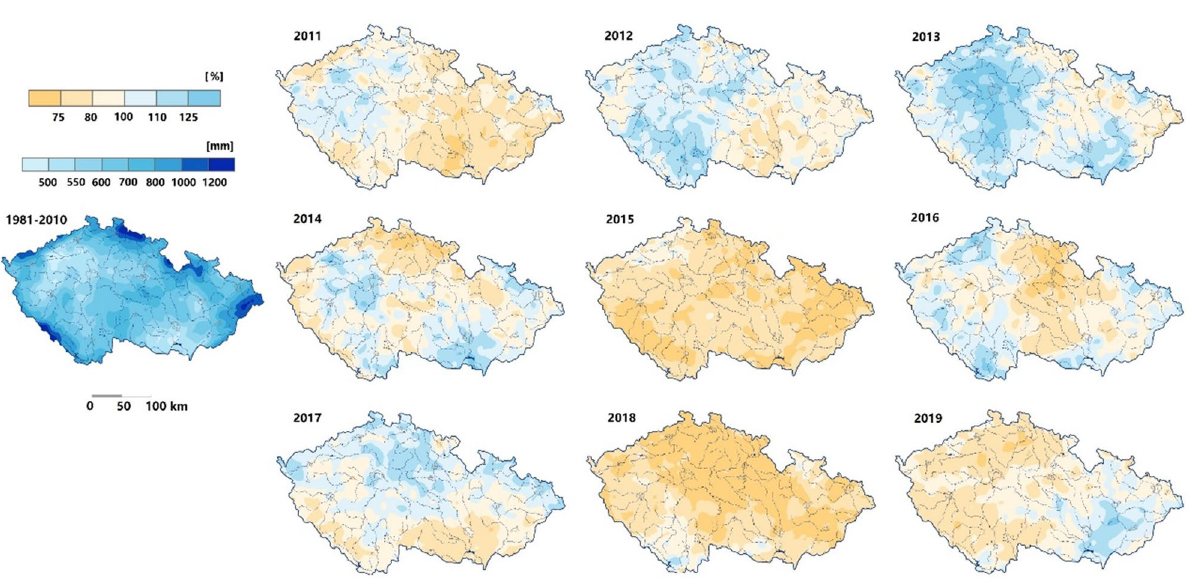
Figure 5. Comparison of mean annual precipitation of each year from 2011 to 2019 with the mean values of 1981–2010 ( modified from CHMI). The left map shows the average value of precipitation of 1981–2010, the individual year’s precipitation was colored based on the difference with average value of